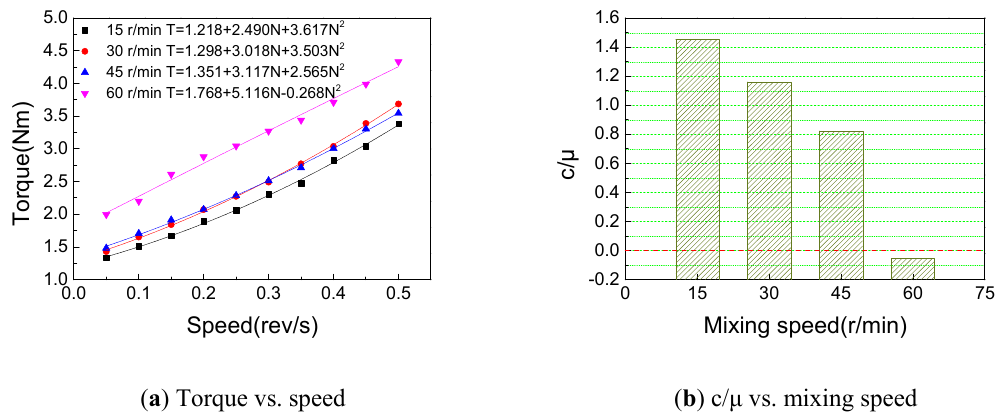
Figure 10. Effect of mixing speed on the shear thickening behavior of SCC. Figure 10. E ff ect of mixing speed on the shear thickening behavior of